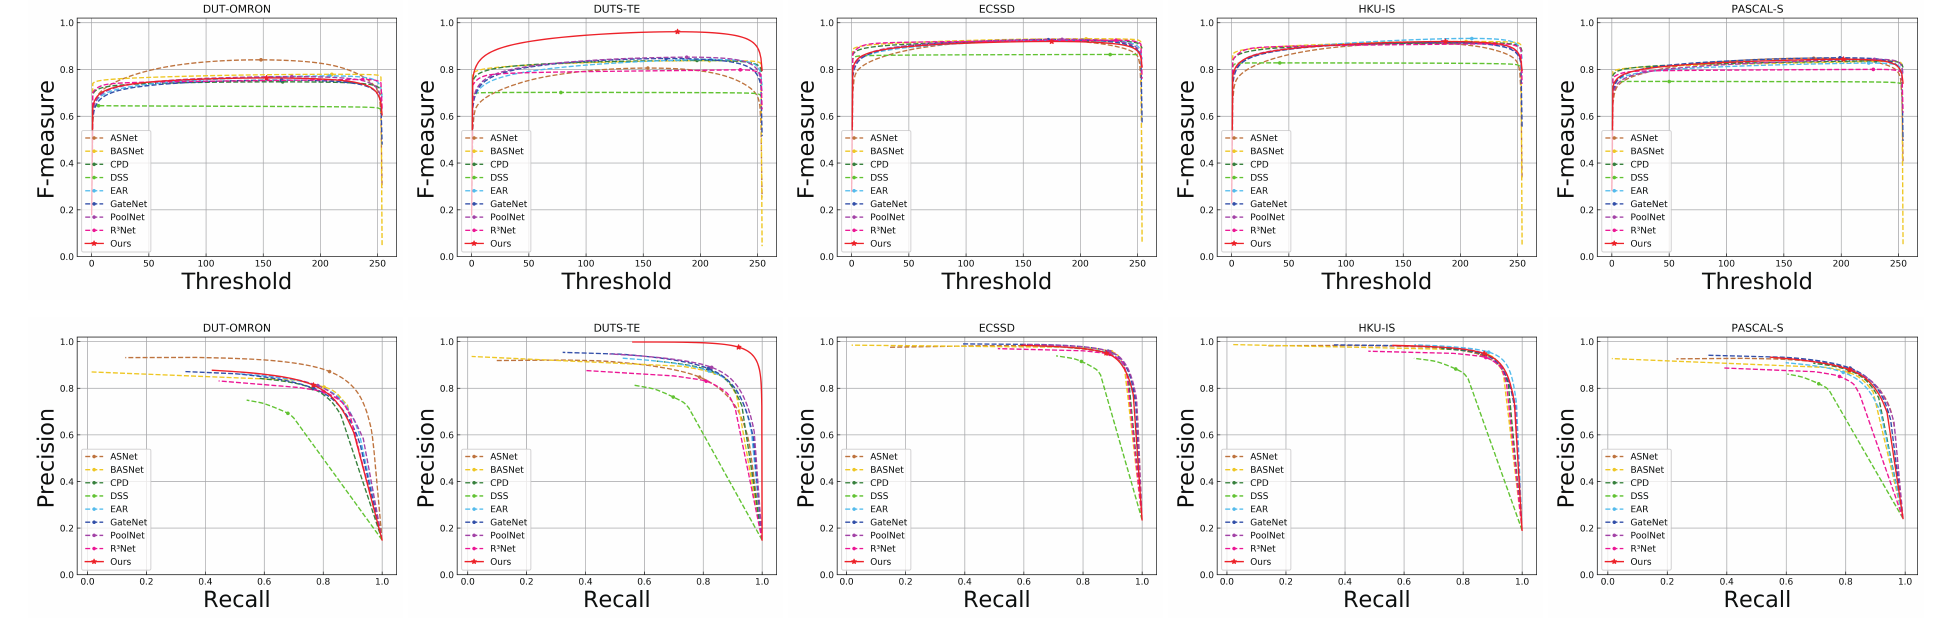
Figure 4. Illustration of F-measure curves ( the first row ), PR curves ( the second row ) on 5 benchmark